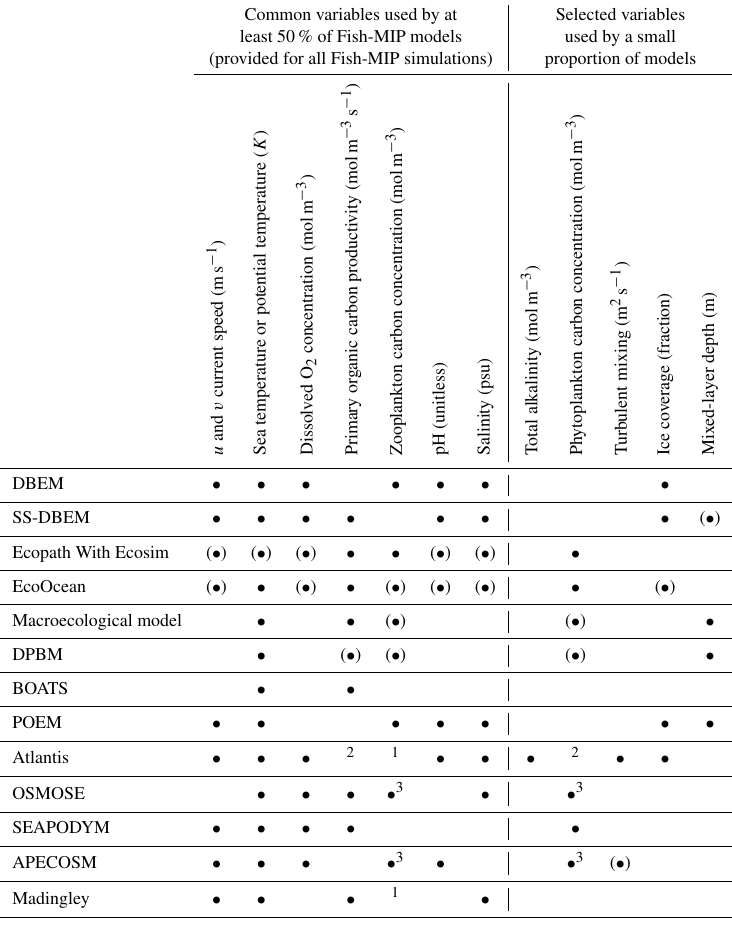
Table 2. Selected Earth system model outputs that are required or optional for individual Fish-MIP models. Fish-MIP models can require surface values, a mean or summed surface layer value (e.g. top 100m), surface and sea-floor values, or fully three-dimensional values. Note that this list is correct at the time of writing, but that models are continuously in development with new components and requirements being added. Units follow CMIP5 standard output